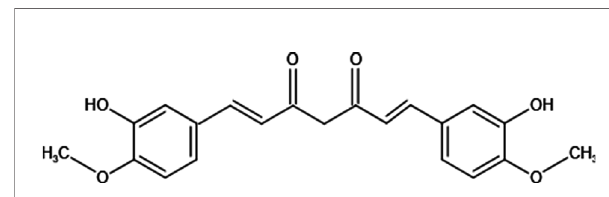
FIGURE 1 | Chemical structure of curcumin.